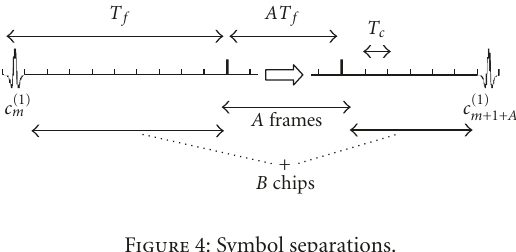
Figure 4: Symbol